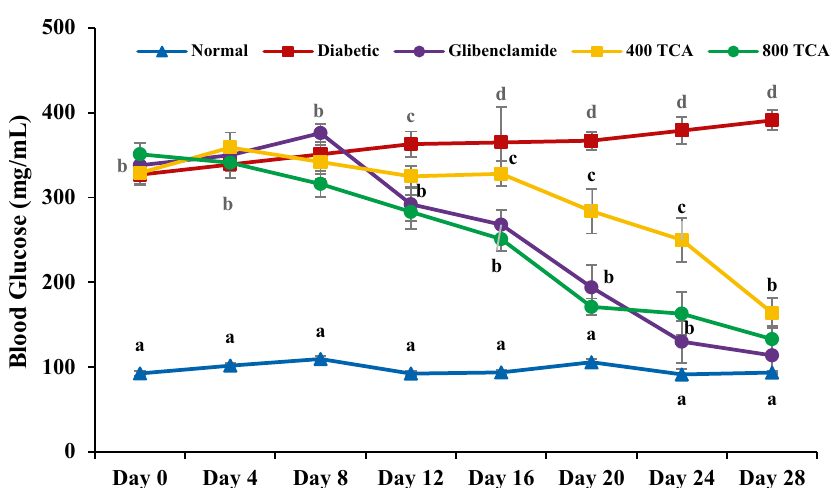
Figure 3. Effect of T. catappa aqueous extract treatment on HFD/STZ-induced diabetic rats’ mean fasting blood glucose changes during the experimental period. Markers are expressed as mean ± SEM (n = 6). Markers with different superscripts for a given day are significantly different at p < 0.05. Markers with similar superscripts for a given day are not significantly different at p <